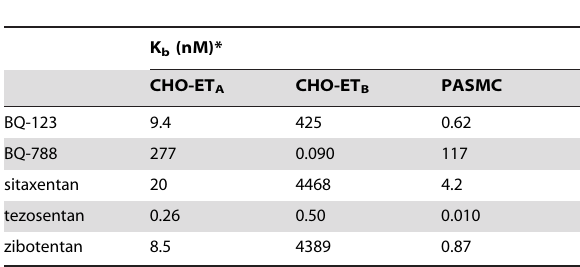
Table 1. Mean K b values for reference ERAs determined by calcium release assays in CHO-ET A , CHO-ET B and human PASMC.